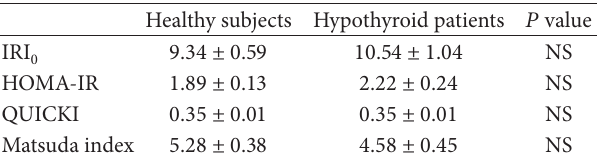
in the OGTT were significantly higher in women with Table 2: Comparison of insulin-resistant indicators in healthy and hypothyroid